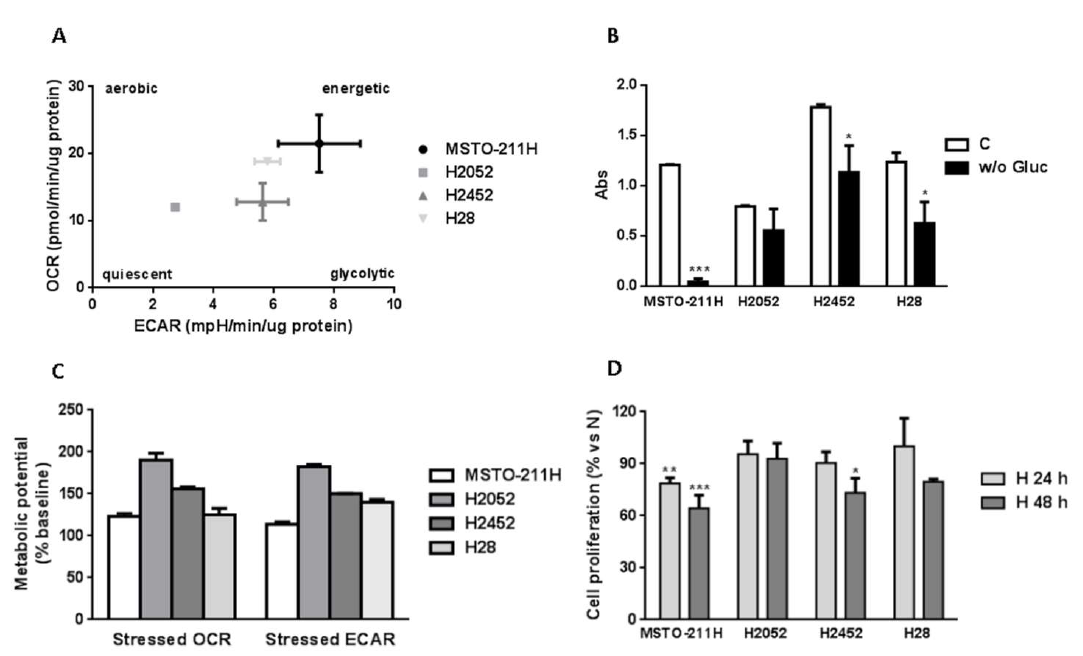
Figure 1. Metabolic features of MPM cell lines. ( A ) The metabolic profile of MSTO-211H, H2052, H2452, and H28 cell lines was defined performing the Agilent SeaHorse Cell energy phenotype assay. After 24 h of growth in complete medium, ECAR and OCR were measured at baseline and after the addition of oligomycin and FCCP. The metabolic potential of each cell line is reported in panel ( C ). Data are representative of two independent experiments. ( B ) MPM cells were maintained for 24 h under glucose starvation (w / o Gluc) and then cell viability was evaluated by CV assay. Data are representative of three independent experiments. * p < 0.05, *** p < 0.001 vs. control, ( C ). ( D ) MPM cells were grown under hypoxic conditions (1% O 2 ) for 24 or 48 h and then cell viability was evaluated by CV assay. Data are expressed as percent versus control cells cultured under normoxic condition (N) and are the media ± SD of three independent experiments. * p < 0.05, ** p < 0.01, *** p < 0.001 vs.